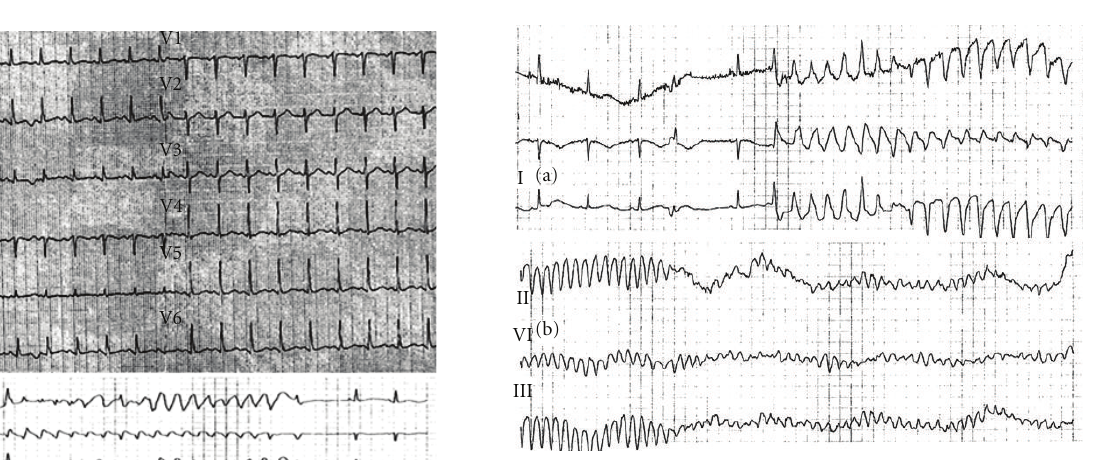
Figure 3: (a, b) TdP degenerating to ventricular